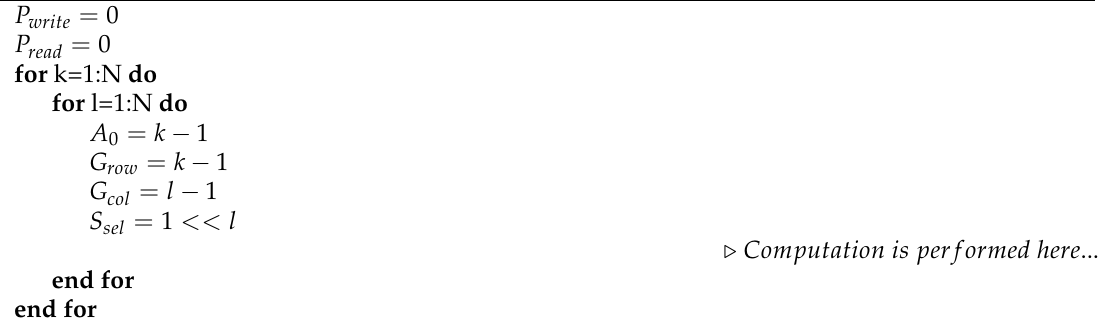
Algorithm 5 Addressing scheme for P ± G and P · G computation.